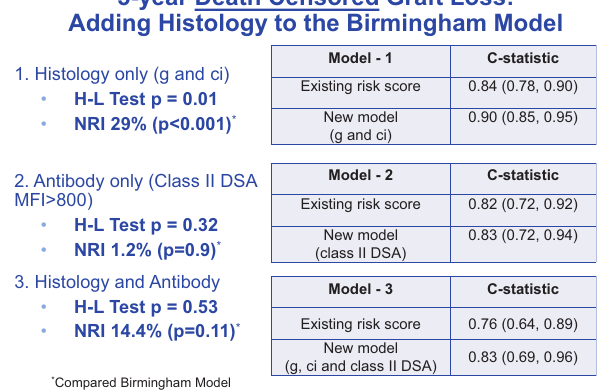
FIGURE 1 | Data showing that the risk score C -statistic is improved by adding histology and calibration improves by adding antibody